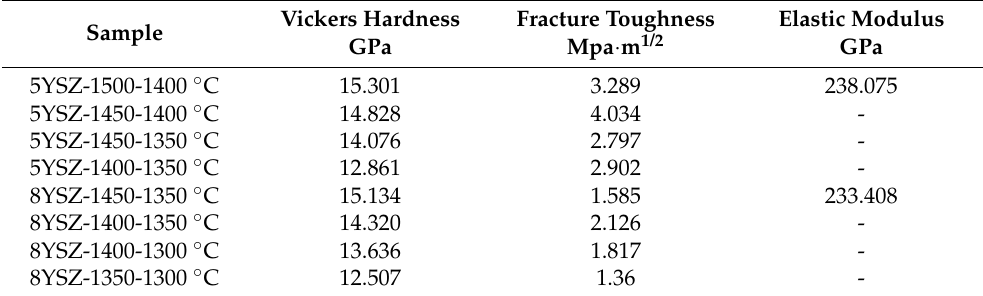
Table 3. Relationship between mechanical properties, relative density, and grain size of different samples at 2 h holding time.